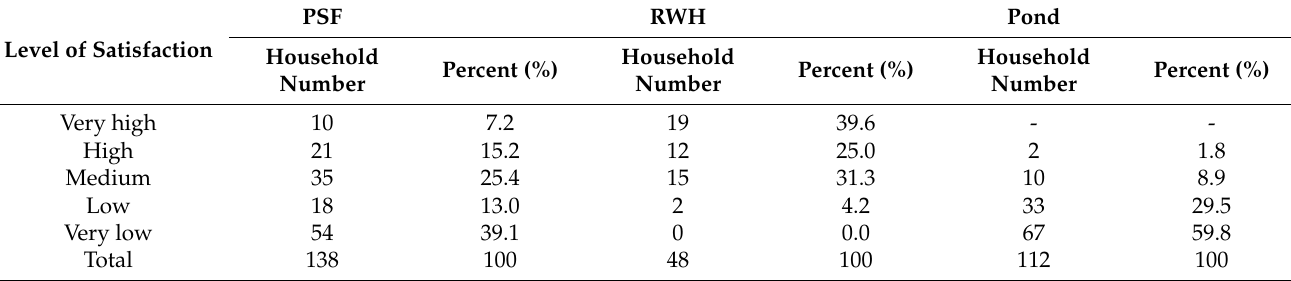
Table 7. Level of satisfaction among different water users in Southkhali